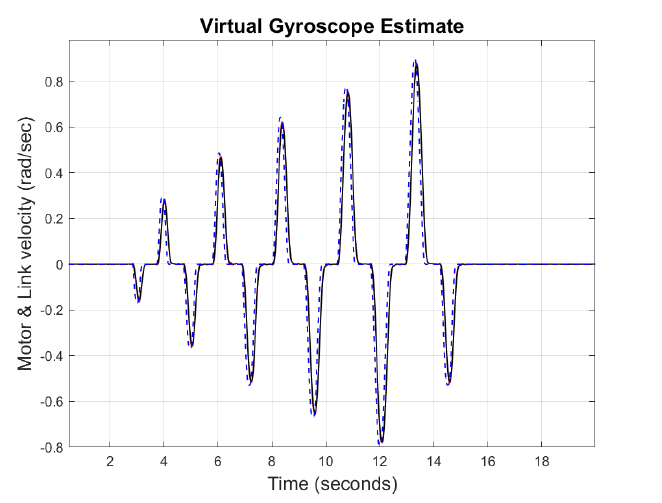
Figure 23. Velocity reference (dashed blue line), motor velocity (black line), link estimated velocity (dark red line).